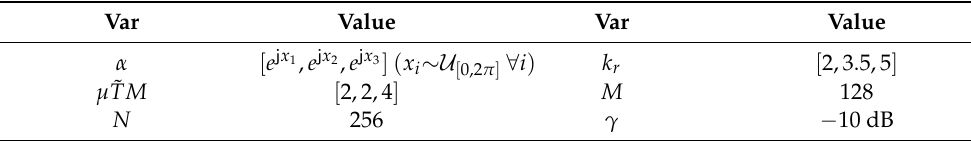
Table 1. Target parameters, where three targets are simulated, U [ x , y ] denotes the uniform distribution in [ x , y ] and γ denotes the SNR 1